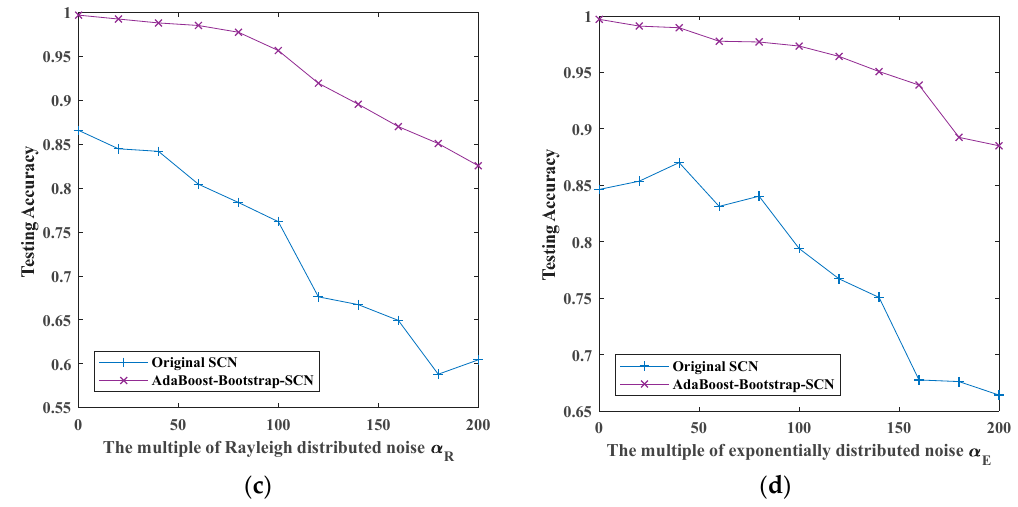
Figure 14. The maximum testing accuracy of original SCN and AdaBoost-Bootstrap-SCN with different noises: ( a ) white Gaussian noise; ( b ) white uniform noise; ( c ) Rayleigh distributed noise; ( d ) exponentially distributed noise.